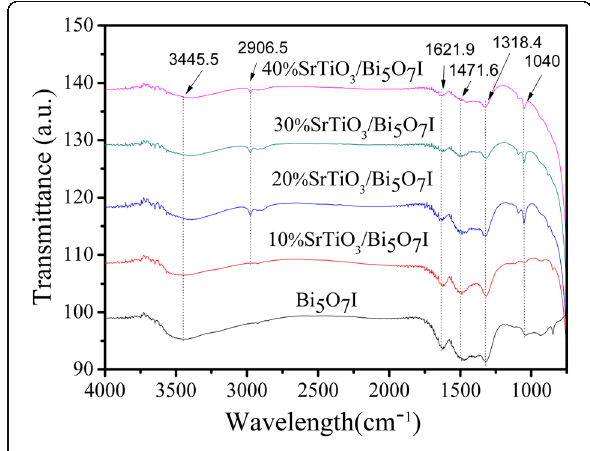
Fig. 5 FTIR spectra of the pure Bi 5 O 7 I and SrTiO 3 /Bi 5 O 7 I nanocomposites